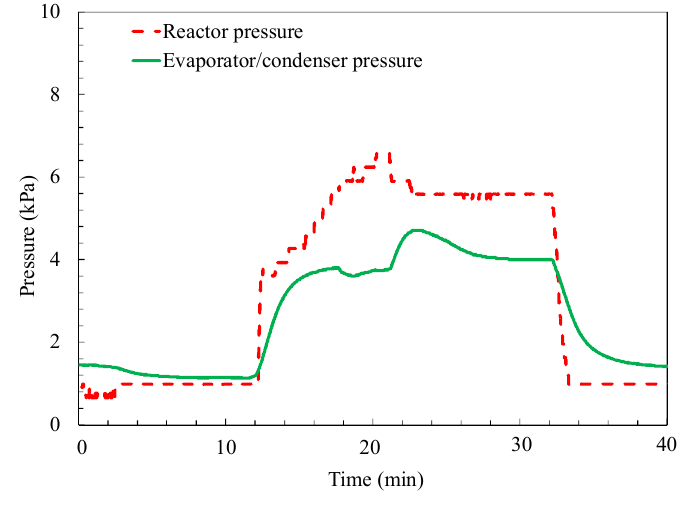
Figure 8. The temporary pressures inside the reactor and evaporator/condenser.